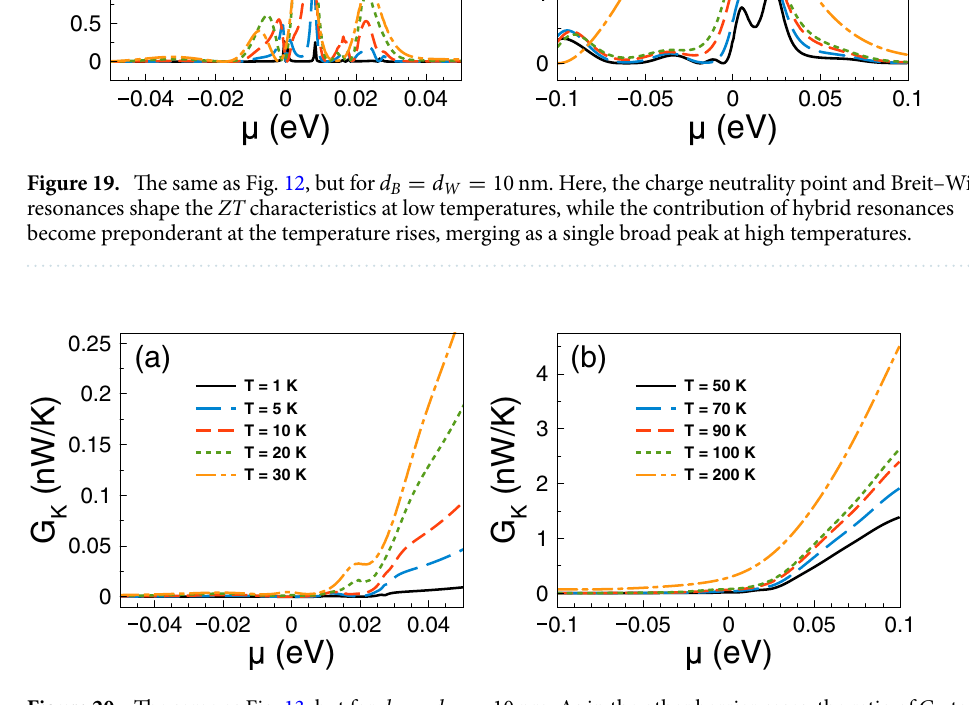
2 to ZT is diminished by G K /( GT ) , resulting in ZT s an order 2 can be found in the